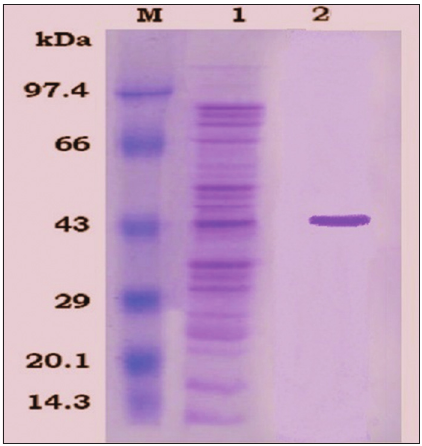
dodecyl sulfate-polyacrylamide